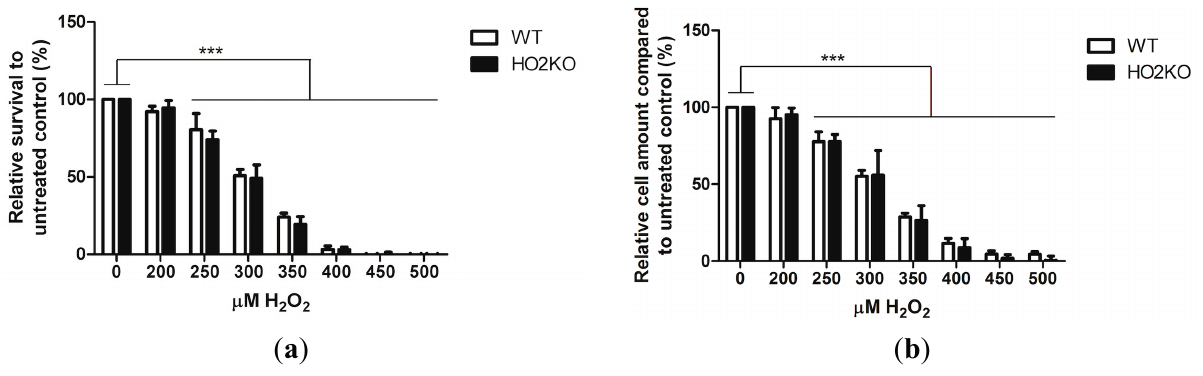
Figure 2. Survival and cell amount of isolated WT and HO-2 KO ASCs after exposure to increasing doses of H 2 O 2 (0–500 µM) for 24 h. ( a ) WT and HO-2 KO ASC survival and ( b ) amount of ASCs after H 2 O 2 -treatment were analyzed using the Alamar blue assay and picogreen assay, respectively. Doses of 250 µM H 2 O 2 and higher resulted in a significant decreased survival and, subsequently, lower cell amounts (all p < 0.001) compared to untreated control. No significant differences were observed between WT and HO-2 KO ASCs at any concentration. A dose of 350 µM H 2 O 2 was chosen in further experiments to induce ASC death. Data represent mean ± SD of three independent experiments with four samples per condition. * is significant different from treated control. ( *** p <